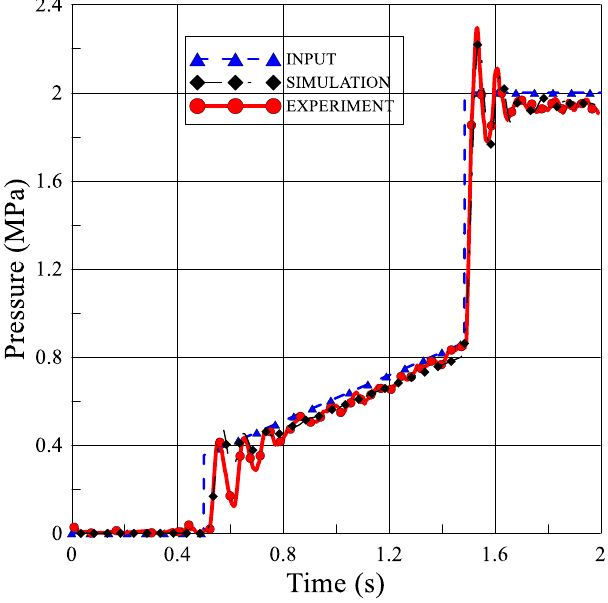
Figure 10. Buffer characteristics experiment and simulation comparison curve.